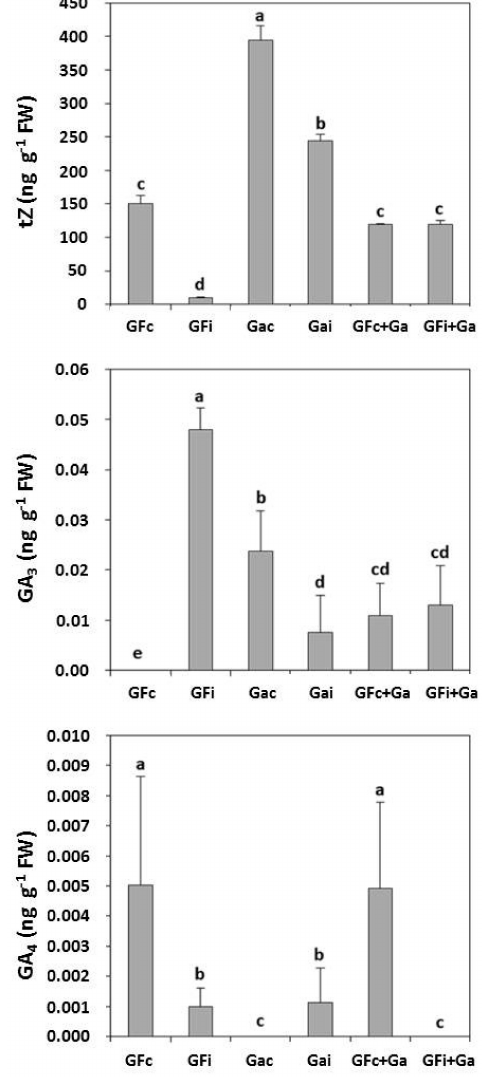
Figure 2. Concentrations (ng · g − 1 fresh weight, FW) of the plant growth-related hormones, including the cytokinin trans-zeatin (tZ) and the gibberellins GA 3 and GA 4 in control (GFc) and infected (GFi) “GF305” peach showing strong sharka symptoms; control (Gac) and infected (Gai) “Garrigues” almond; control “GF305” grafted onto “Garrigues” almond (GFc+Ga); and infected “GF305” grafted onto “Garrigues” almond